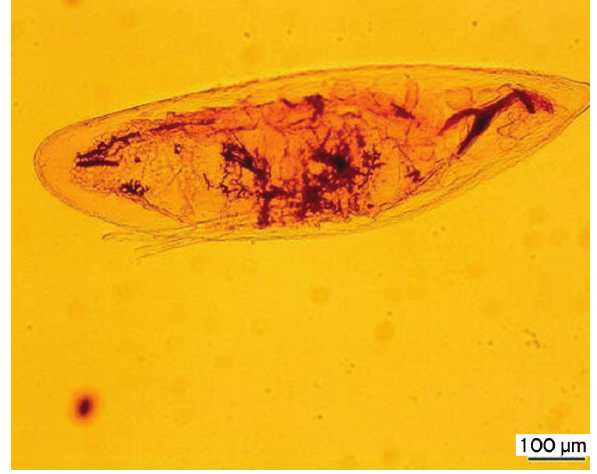
Figura 5. Morfologia do ovo de Neosilba perezi em vista ao microscópio